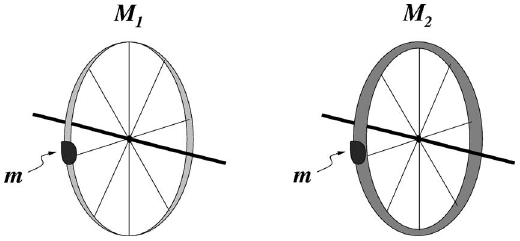
FIG. 2. The two wheels shown in the figure have the same radius but different masses (cid:1) M 1 (cid:4) M 2 (cid:2) uniformly spread at the rim of each wheel. A small piece of putty with mass m is attached to the rim of each wheel. The two systems are shown right after the piece of putty is fastened to the